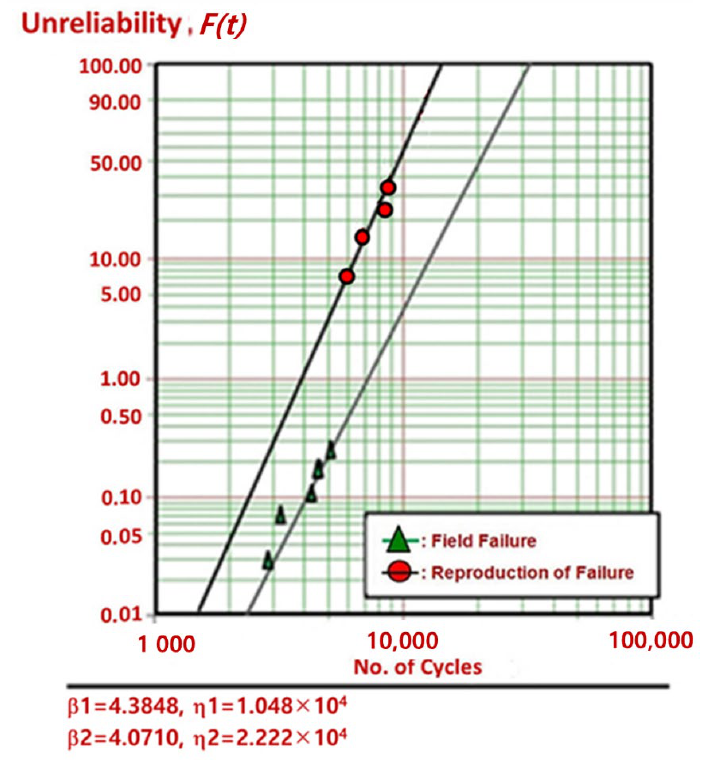
Figure 13. Unsuccessful products on the Weibull plot: ( a ) failed products at the market and ( b ) failed products after first ALT.